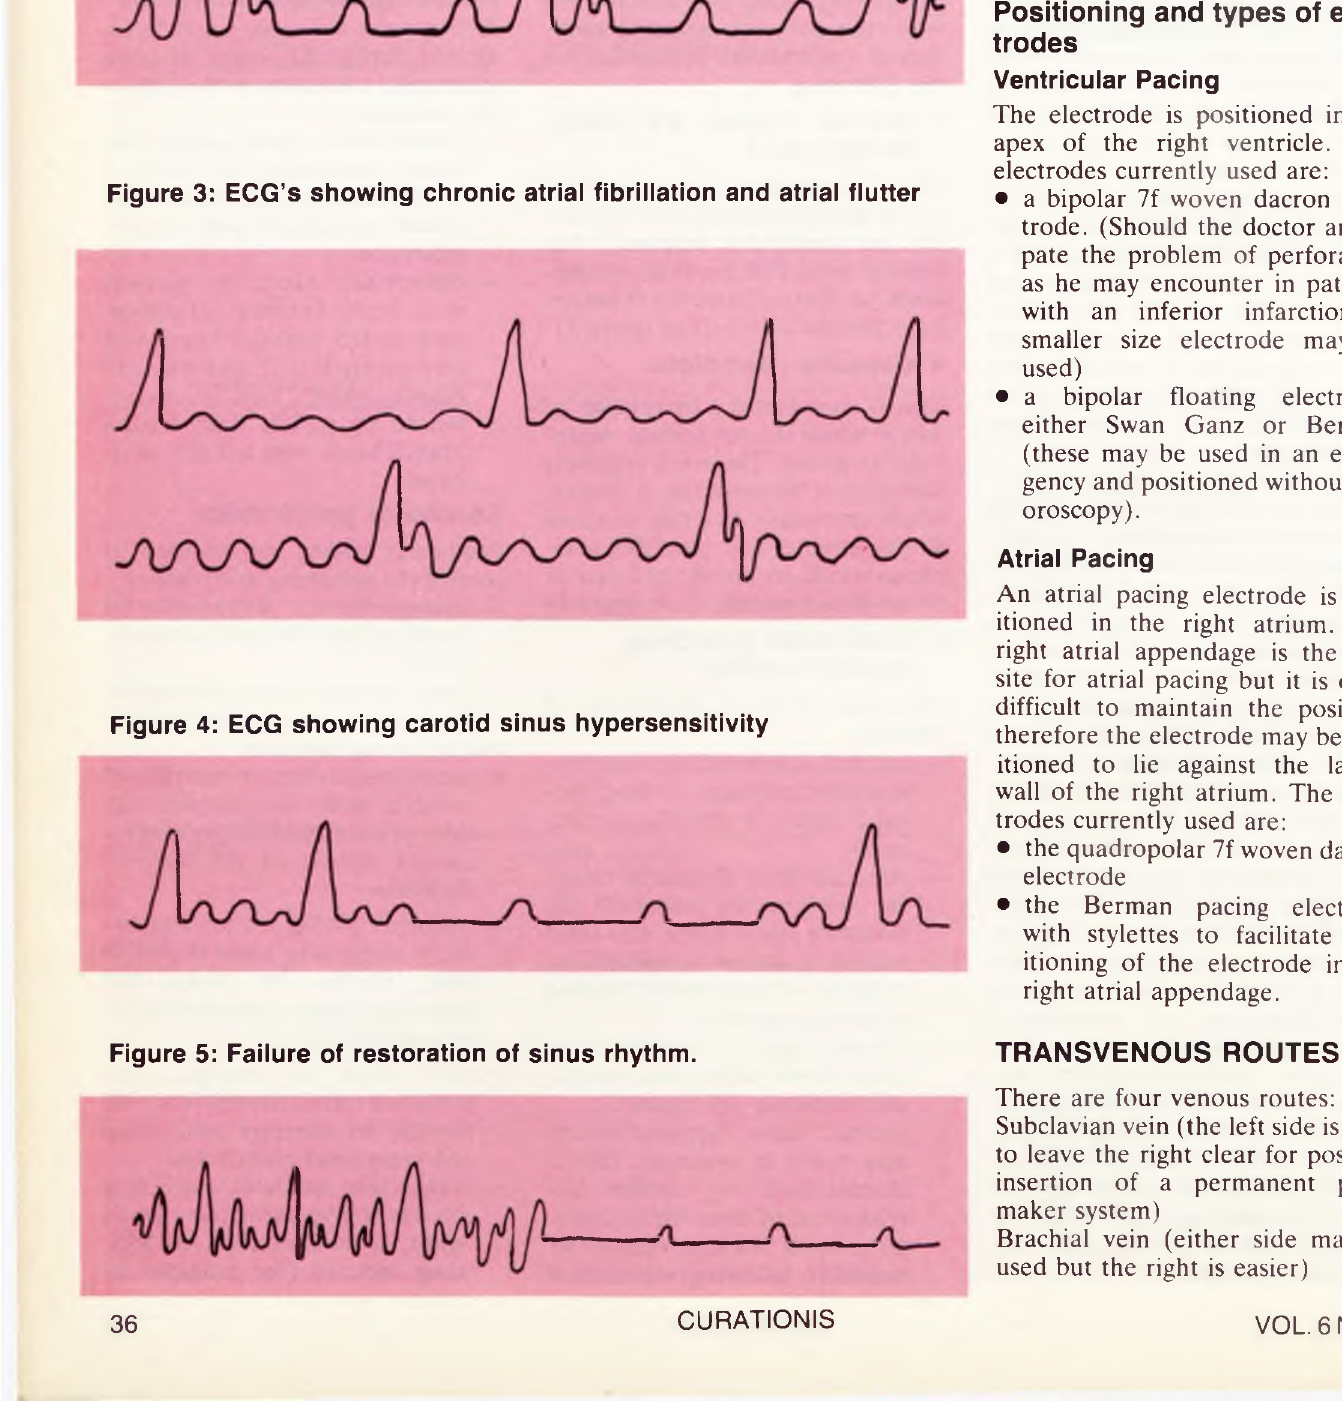
Figure 2: ECG of complete heart block